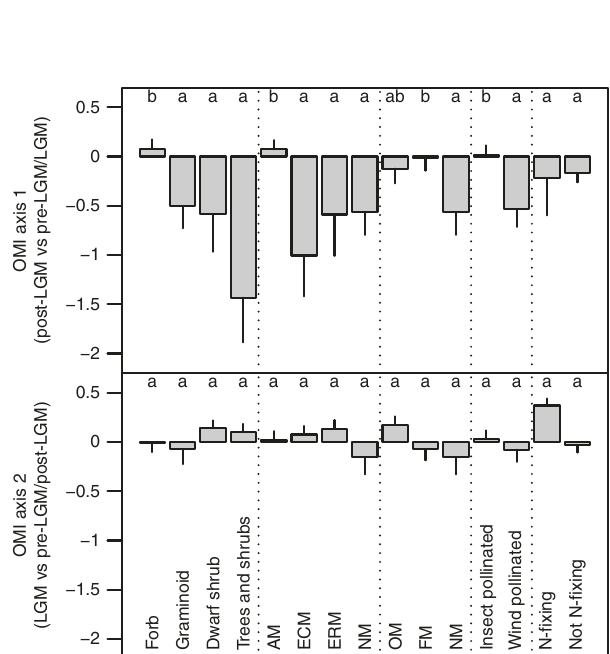
Fig. 3 Outlying mean index (OMI) axis scores of plants with different mutualist traits. OMI axis scores represent an estimate of species ’ niche positioning. The fi rst axis corresponds to the distinction between post-LGM (more negative values) and earlier periods (more positive values), while the second corresponds to the distinction between LGM (more negative values) and other periods (more positive values). The mean value ( ± SE) for each trait category is